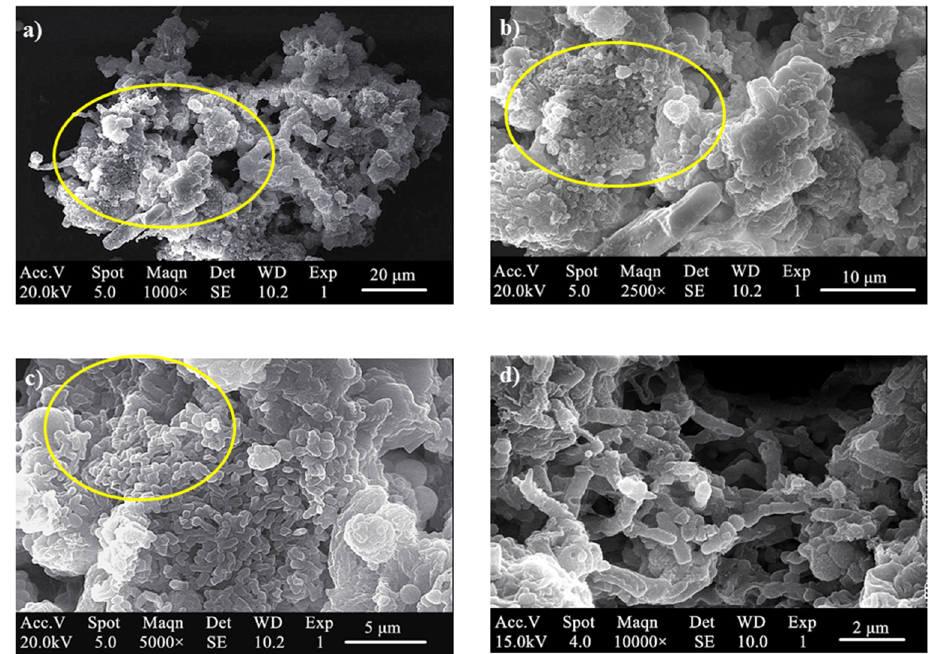
Figure 4. The SEM observations of di ff erent size of sludge: ( a ) 20 µ m; ( b ) 10 µ m; ( c ) 5 µ m; ( d ) 2 µ m.